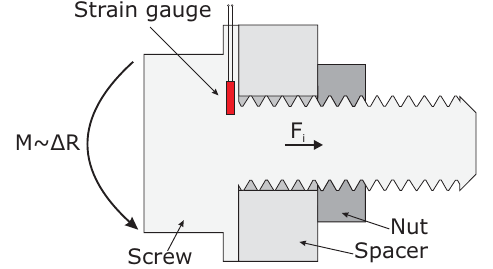
Figure 1. Measurement concept of a “smart” screw, with a thin strain gauge integrated into a spacer disk between the head and shaft of a screw, where torsional moment M proportional to resistance change (cid:49)R allows determination of the prestressing force F i .